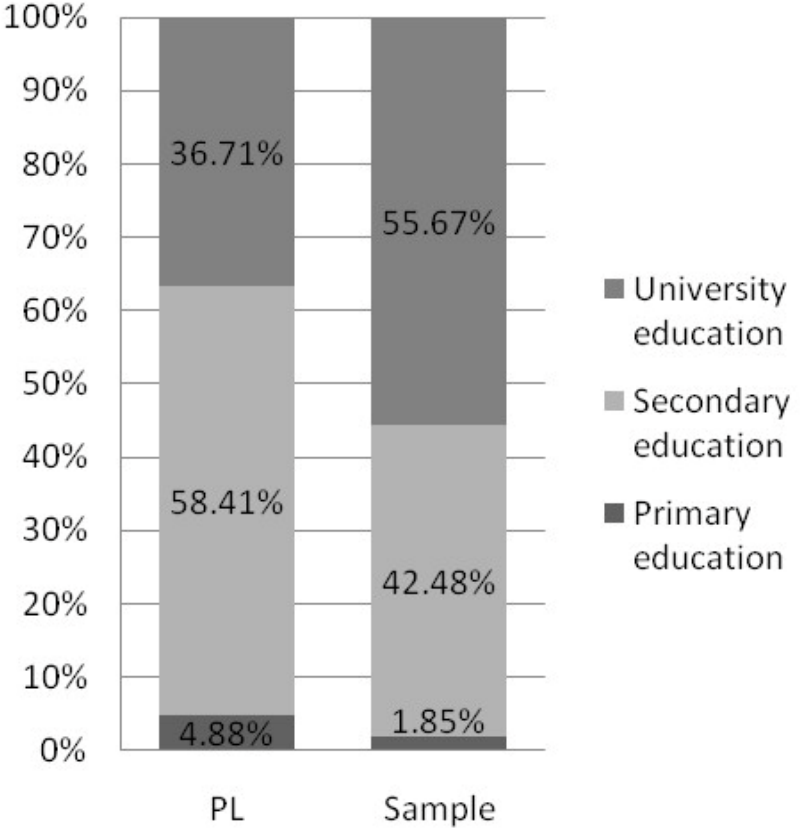
Figure 5. Chart presenting differences in the level of education between the study groups (based on Statistic Poland). Note: Status report on target Polish working population in the 4th of quarter 2020 according to “Yearbook of Labour Statistics 2021”; Statistics Poland